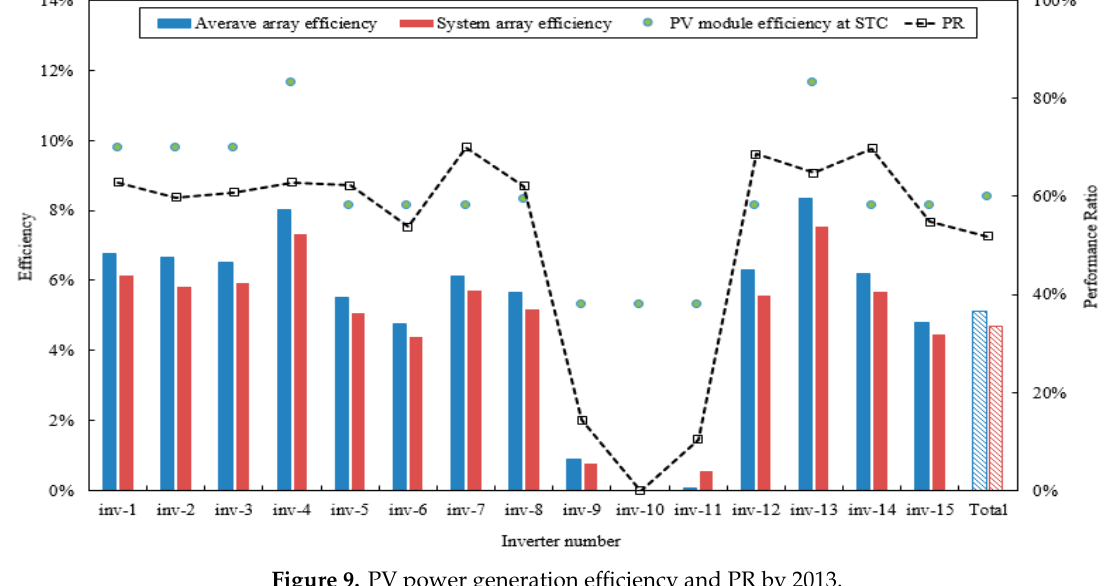
Figure 9. PV power generation efficiency and PR by 2013.